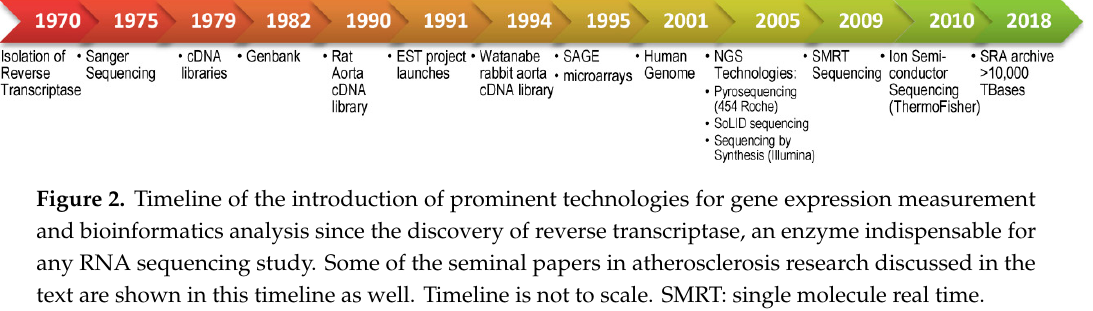
protocol to remove all common sequences between control and experimental cDNA libraries (i.e., cell